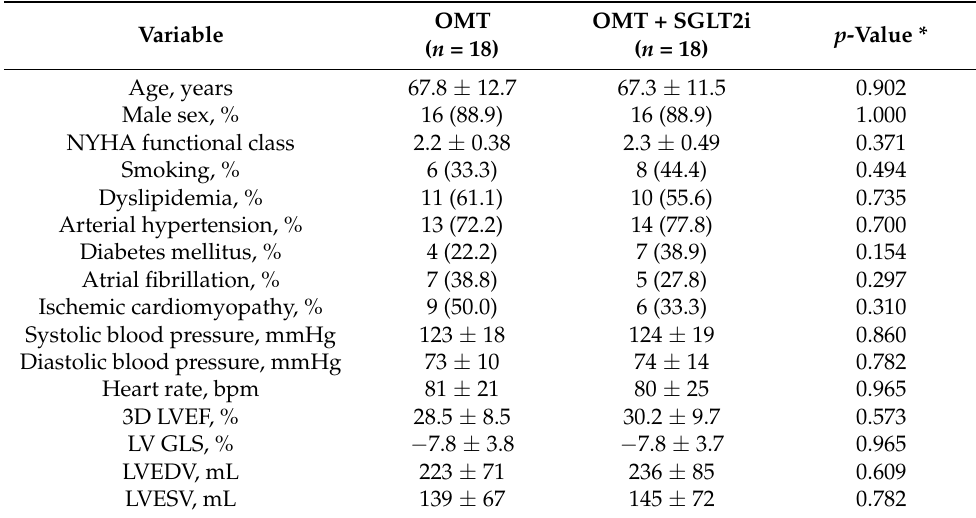
Table 1. Baseline characteristics of two treatment groups (OMT vs. OMT + SGLT2